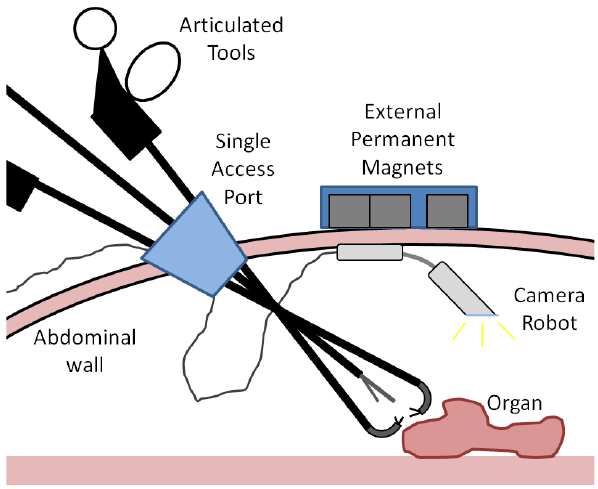
Figure 1. Schematic representation of an SPL surgical scenario using the novel camera robot based on the compliant MLS.